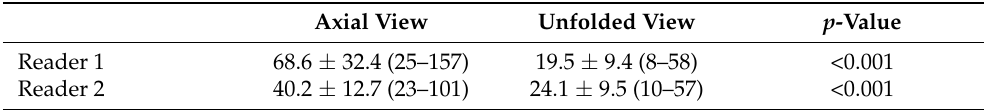
Table 5. Reading times for the axial and unfolded view and the respective p -values. Reading times are given in seconds as mean ± SD